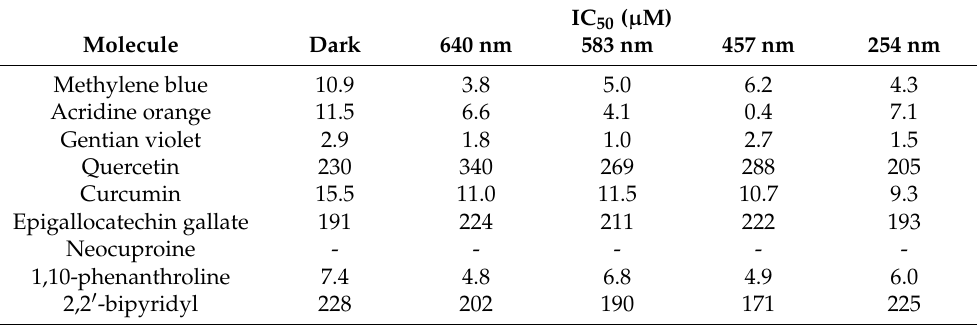
Table 2. Comparison of IC 50 values from a phototoxicity assay in MET1 cells treated with dyes (methylene blue, acridine orange and gentian violet), natural compounds (quercetin, curcumin and epigallocatechin gallate) and chelating molecules (neocuproine, phenanthroline and 2,2 (cid:48) -bipyridyl) exposed (or not, i.e., dark control) to a 2.5 J/cm 2 light dose at different wavelengths. IC 50 ( µ M) Molecule Dark 640 nm 583 nm 457